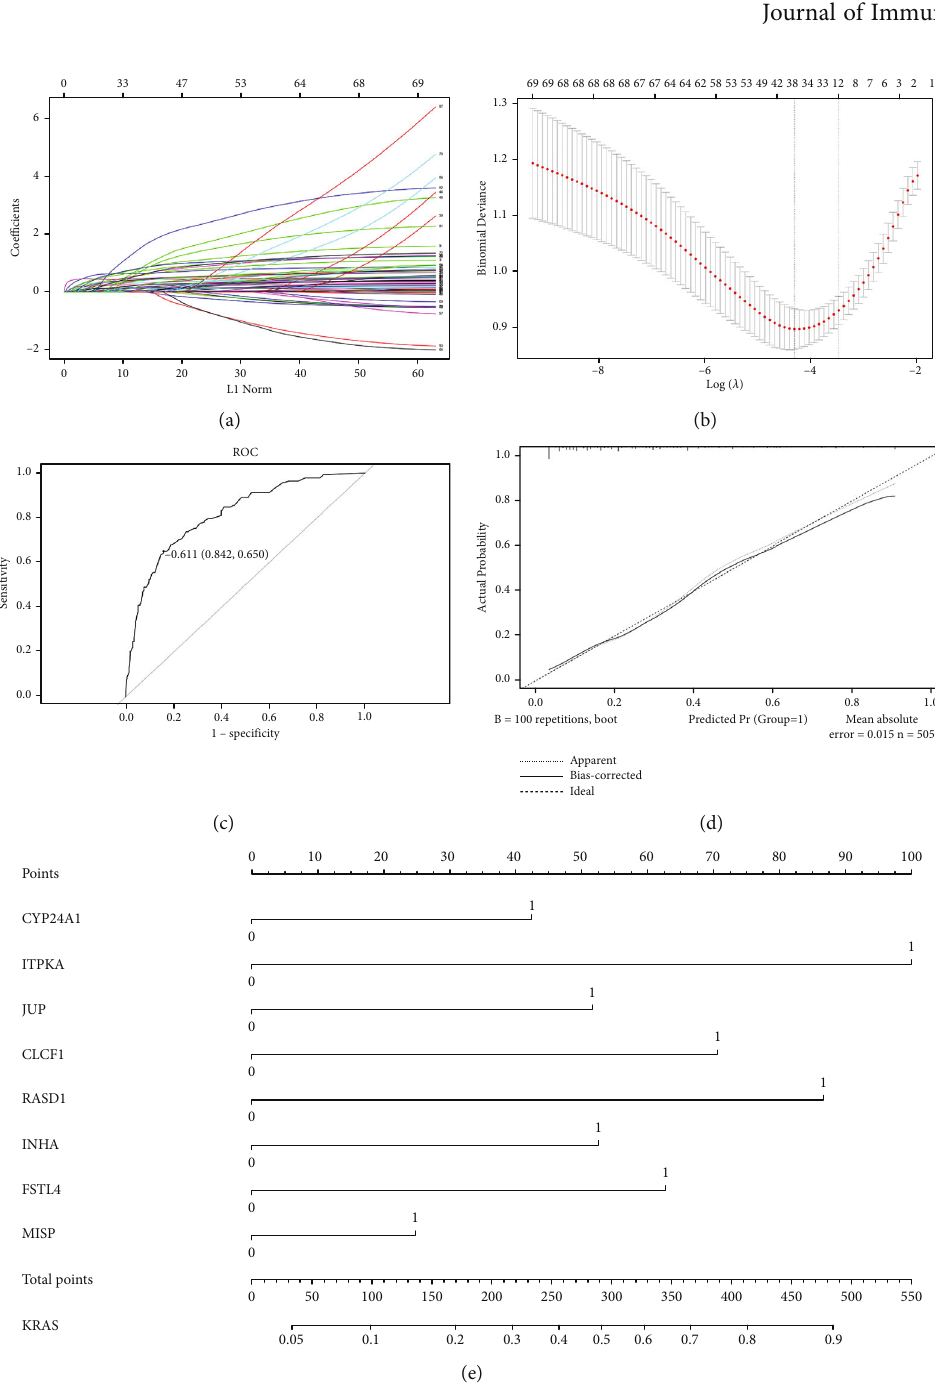
Figure 6: (a) Coe ffi cient pro fi les of variables in the LASSO regression model; (b) tenfold cross-validation for selecting parameter λ in the LASSO regression model; λ is the turning parameter. The partial likelihood deviance is plotted in log ð λ Þ , in which vertical lines are shown at the optimal values by minimum criteria and 1 − SE criteria; (c) ROC curve of the prediction model; (d) calibration plot for nomogram; (e) nomogram for the prediction